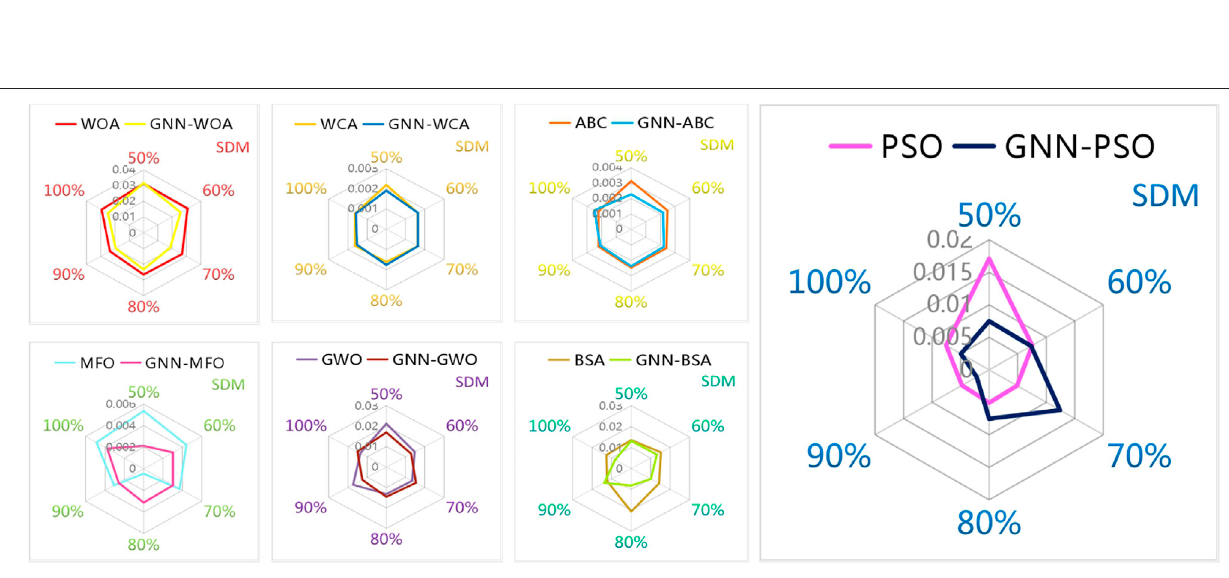
respectively. Apparently, the WCA shows the high fi tting accuracy with actual data under both different training datasets.